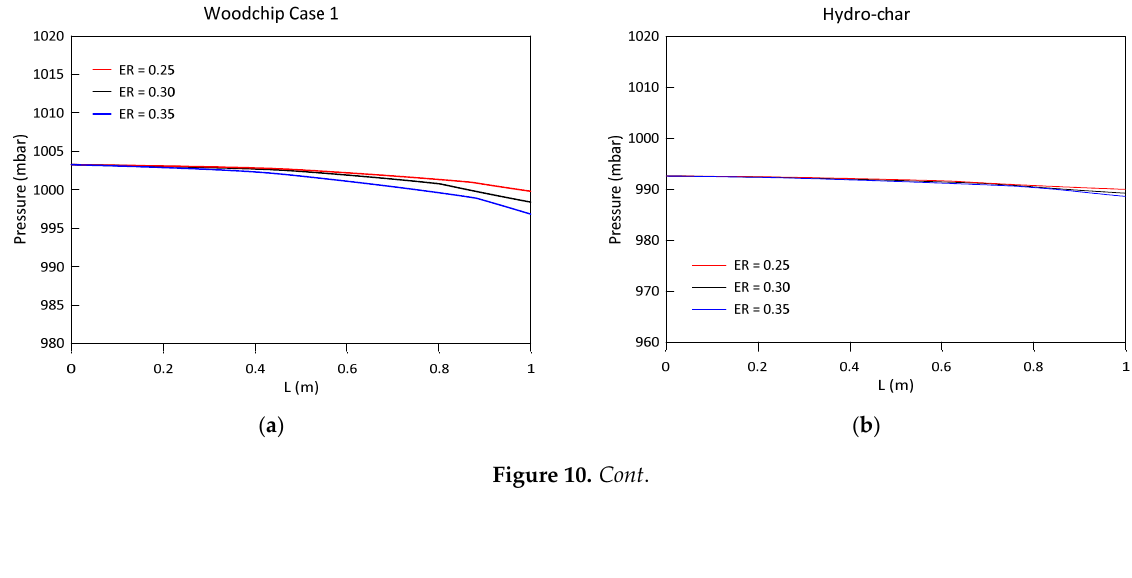
( c ) Figure 10. Pressure evolution along the reactor axis at different ER for ( a ) woodchip case 1, ( b ) hydro-char from green waste, ( c ) olive pomace.